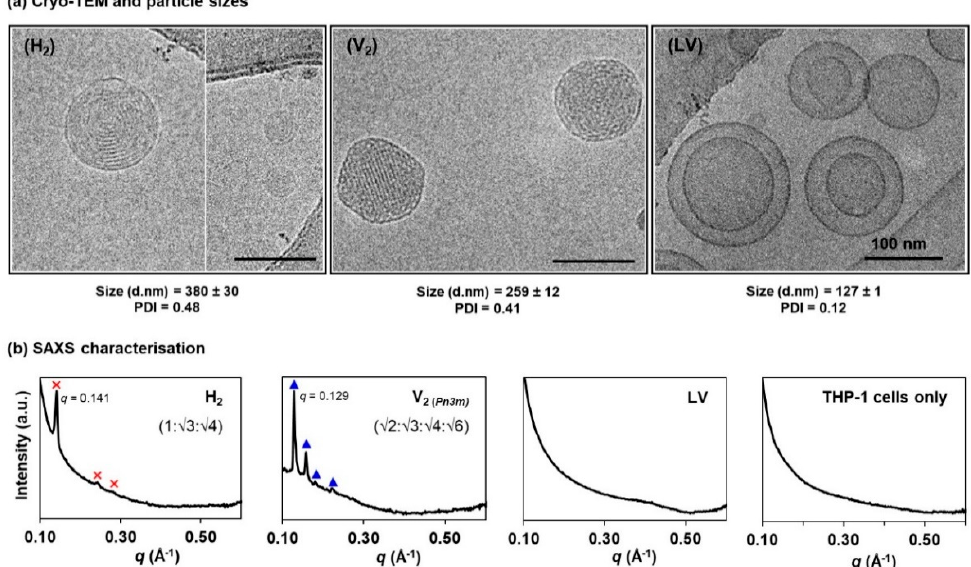
Figure 2. Structural characterisation of the lipid-based liquid crystalline (LLC) nanosystems: ( a ) Cryogenic transmission electron microscopy (cryo-TEM) images, and the corresponding hydrodynamic diameters (d. nm) and polydispersity index (PDI) determined using dynamic light scattering (DLS) technique; ( b ) synchrotron-based small angle X-ray scattering (SAXS) characterisation of the phytantriol-based hexosomes [H 2 , where the Bragg peaks, × , could be indexed as Miller indices ( hk ) = (10), (11) and (20)], cubosomes [V 2 , where the peaks, (cid:78) , corresponded to Miller indices ( hkl ) = (110), (111), (200) and (211]), and liposomes (LV) at 1 mg / mL lipid level, as well as the blank THP-1 cells suspended in cell culture medium (i.e., 1 × 10 7 cells in RPMI-1640 supplemented with 10% FBS).